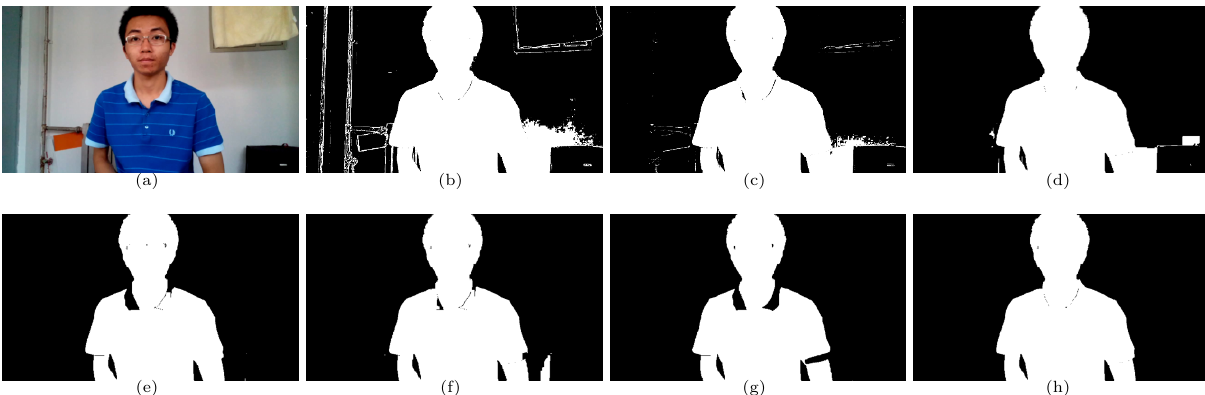
Fig. 7 (a) Input frame. (b) Foreground mask created by fuzzy Gaussian. (c) Adaptive-SOM result. (d) Background cut in RGB space result with a low variance ( σ s r = (5 / 255) 2 ) Gaussian model. (e) Background cut in RGB space result with a larger variance ( σ s r = (20 / 255) 2 ). (f) Background cut in CIE-Lab space result with σ L = σ a = σ b = (5 / 255) 2 . (g) Background cut in CIE-Lab space result with larger variance in the L channel ( σ L = 5 ∗ (5 / 255) 2 ). (h) Result of our method ( σ pe = (10 / 255) 2 ,σ pa = 10 ∗ (10 / 255) 2